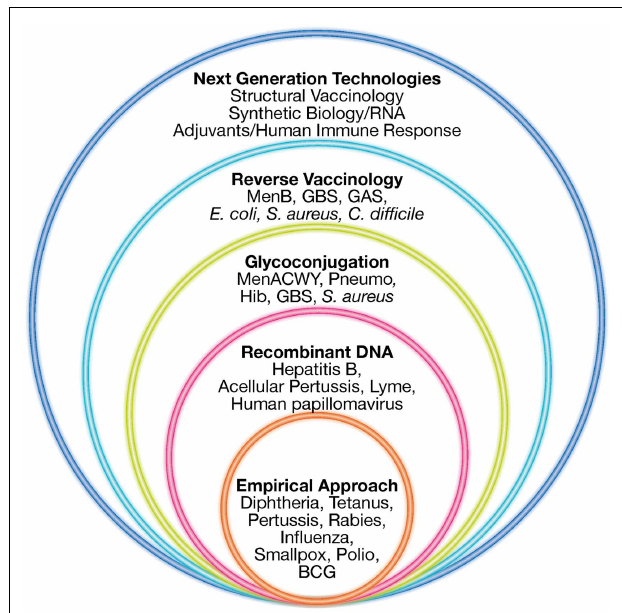
FIGURE 1 |Technologies for vaccine development . Empirical approaches consisting mostly of killed or live-attenuated microorganisms, partially purified components of pathogens (subunit vaccines), detoxified toxins or polysaccharides have represented the starting point in vaccinology, leading to the successful elimination of many devastating diseases. During the last 30years, several novel technologies such as recombinant DNA technology, glyconjugation, reverse vaccinology, and structural vaccinology are opening the possibility of designing new vaccines previously considered impossible to make. Adapted from Rappuoli et al.